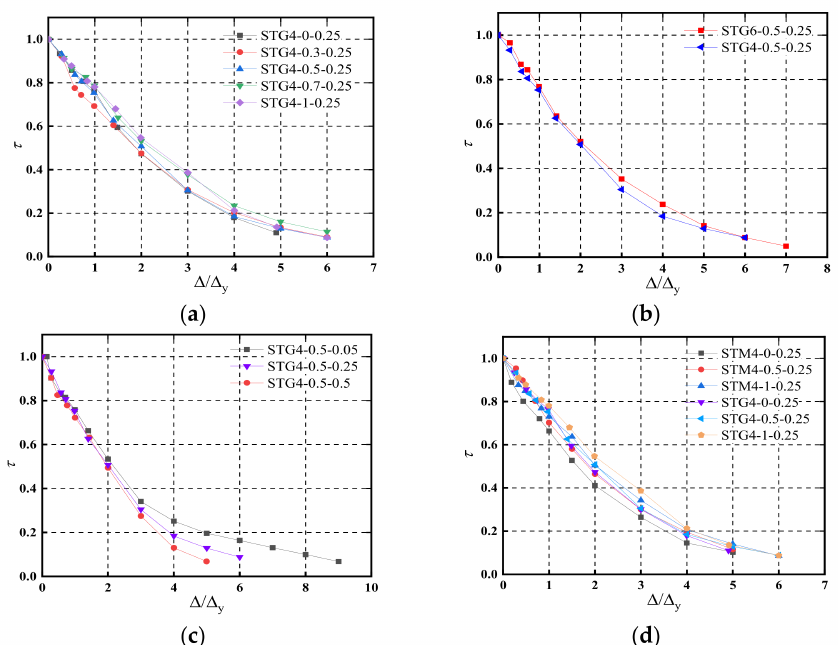
Figure 11. ( a ) Stiffness degradation coefficient curve τ - ∆ / ∆ y for different replacement ratios of RBA; ( b ) stiffness degradation coefficient curve τ - ∆ / ∆ y for different steel tube thicknesses; ( c ) stiffness degradation coefficient curve τ - ∆ / ∆ y for different axial compression ratios; ( d ) stiffness degradation coefficient curve τ - ∆ / ∆ y for different cementitious materials.